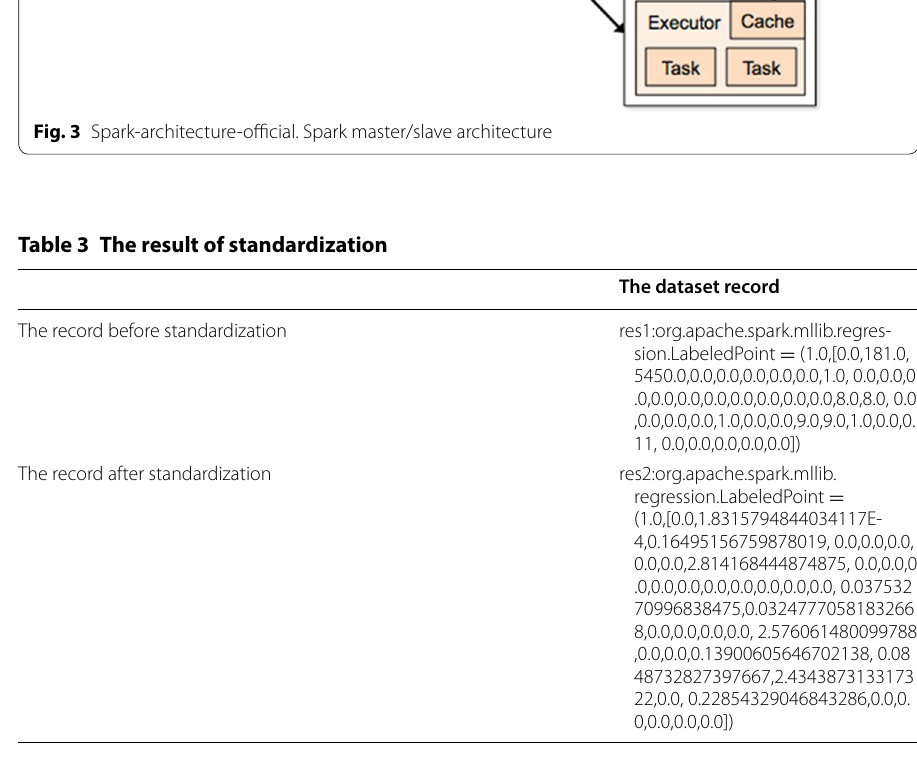
Fig. 3 Spark‑architecture‑official. Spark master/slave architecture